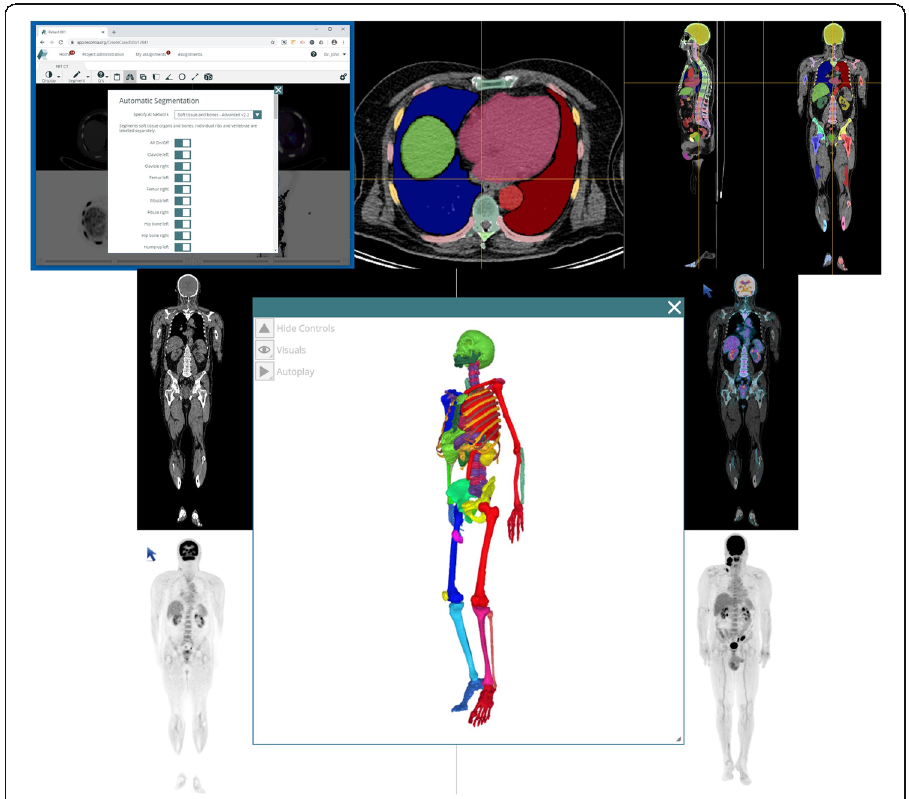
Fig. 4 The AI segmentation tool can be used to segment up to 100 different organs (top left). The automated segmentation results can be viewed as an overlay (top right) or in 3D